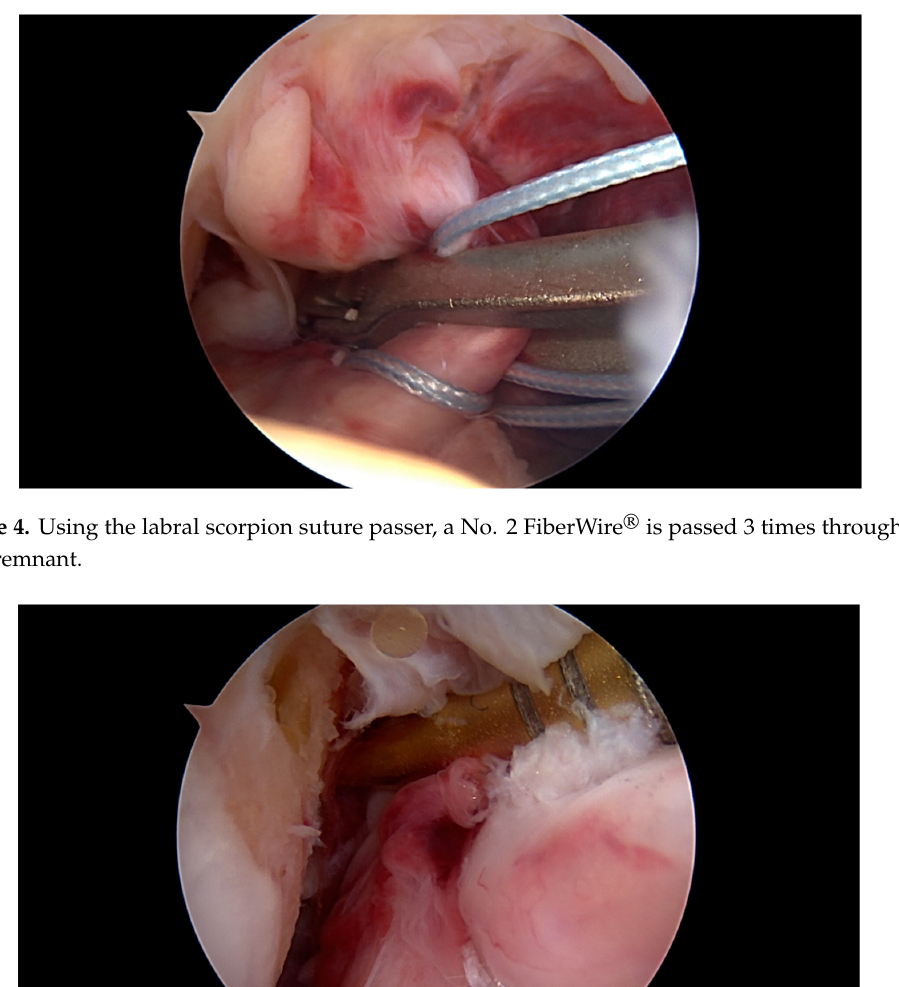
Figure 3. The labral scorpion suture passer is placed approximately 1 cm distal to the ACL tear.